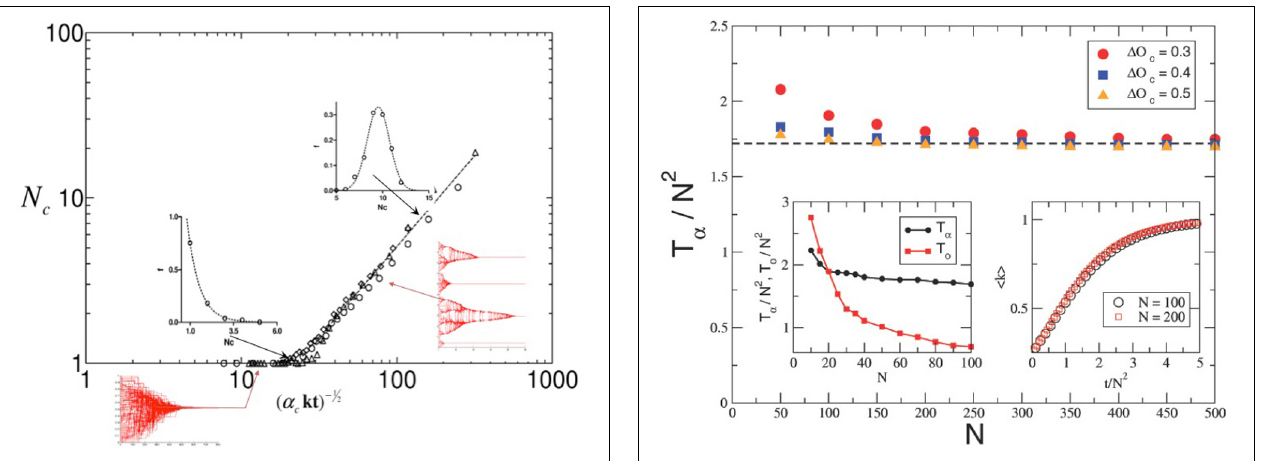
FIGURE 6 | System phase transition. The figure reports the average number of clusters as function of the rescaled quantity ( σα c ) − 1 2 . A phase transition is found at ( σα c ) − 1 2 (cid:5) 20. Above the transition, histograms of the number of clusters are computed and enclosed as insets in the main frame: symbols refer to the numerics, solid lines are fitted interpolation. Here, (cid:3) Oc = 0 . 5.